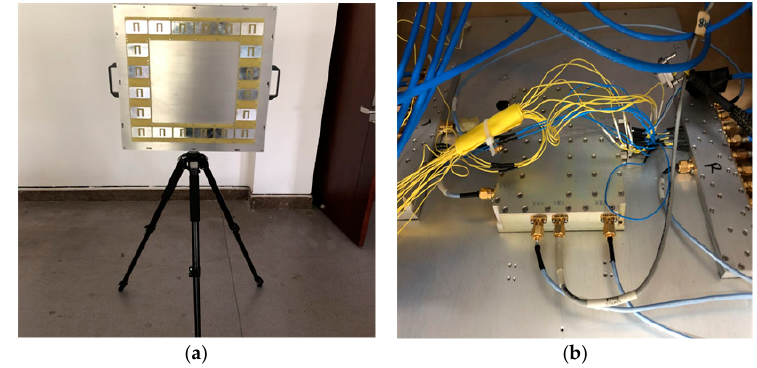
Figure 8. ( a ) Structure of MIMO radar; ( b ) Stepped-frequency transceiver.